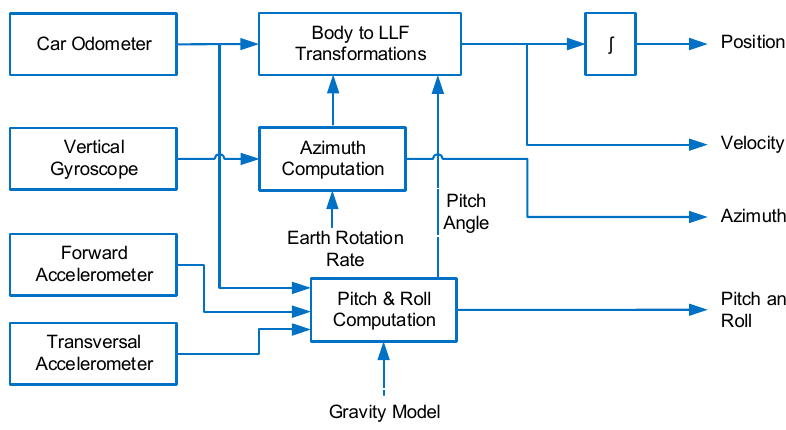
Figure 4. 3D RISS Mechanization.